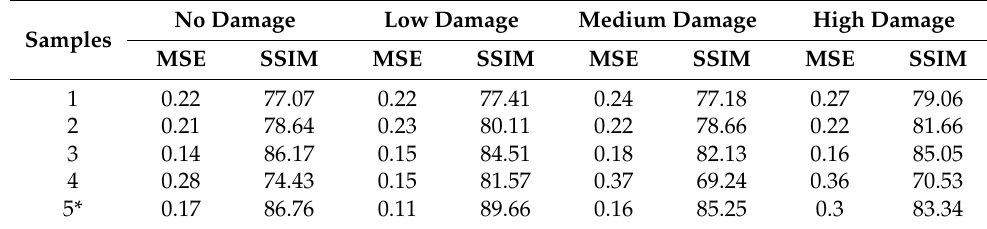
Table 17. Sampled results for five images per class. Samples